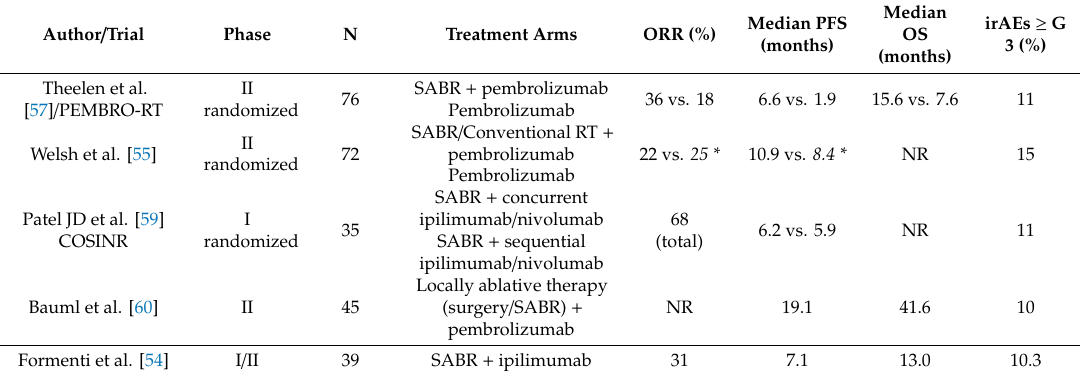
Table 2. Selected randomized and prospective trials testing the combination of RT and ICI in metastatic NSCLC